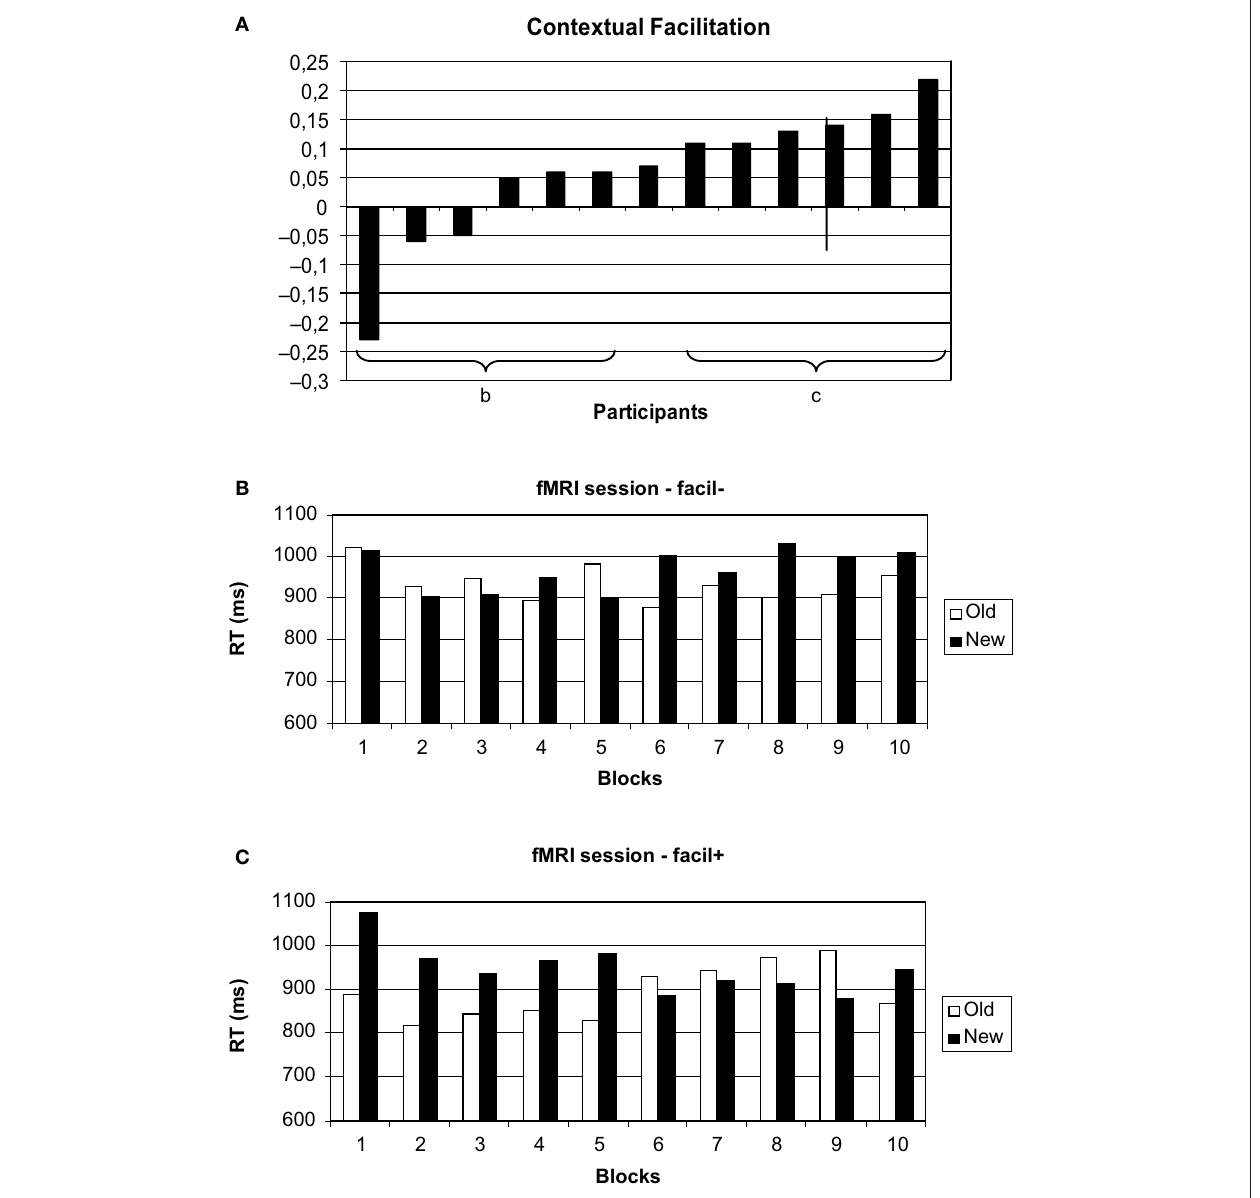
FIGURE 4 | Individual differences in the contextual cueing effect. (A) Normalized individual facilitation scores (see text for details). Search times for the high (B) and low (C) facilitation group.